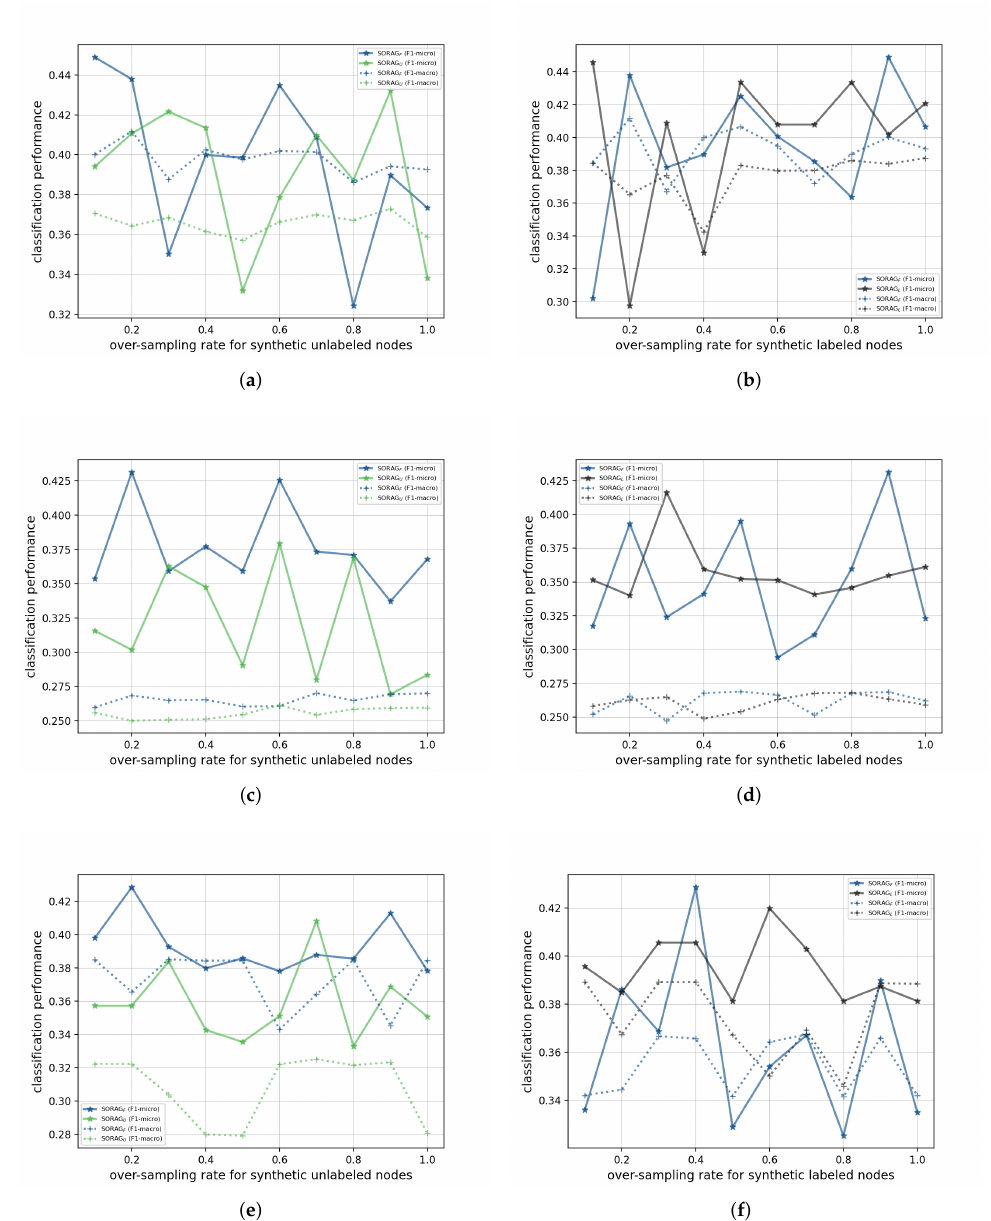
Figure 5. Influence of over-sampling rate on the model performance for each dataset: ( a ) B LOG - C ATALOG 3, UNLABELED NODE GENERATION ; ( b ) B LOG C ATALOG 3, LABELED NODE GENERATION ; ( c ) F LICKR , UNLABELED NODE GENERATION ; ( d ) F LICKR , LABELED NODE GENERATION ; ( e ) Y OU T UBE , UNLABELED NODE GENERATION ; ( f ) Y OU T UBE , LABELED NODE GENERATION